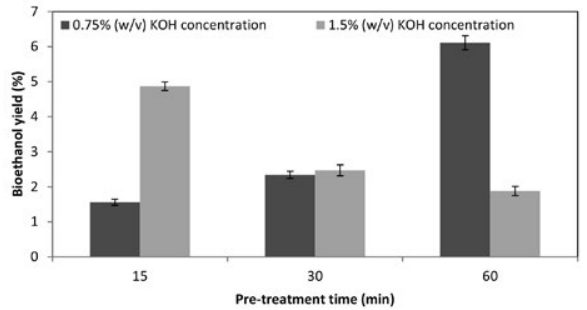
Fig 7. Effect of different alkaline pre-treatment times on bioethanol